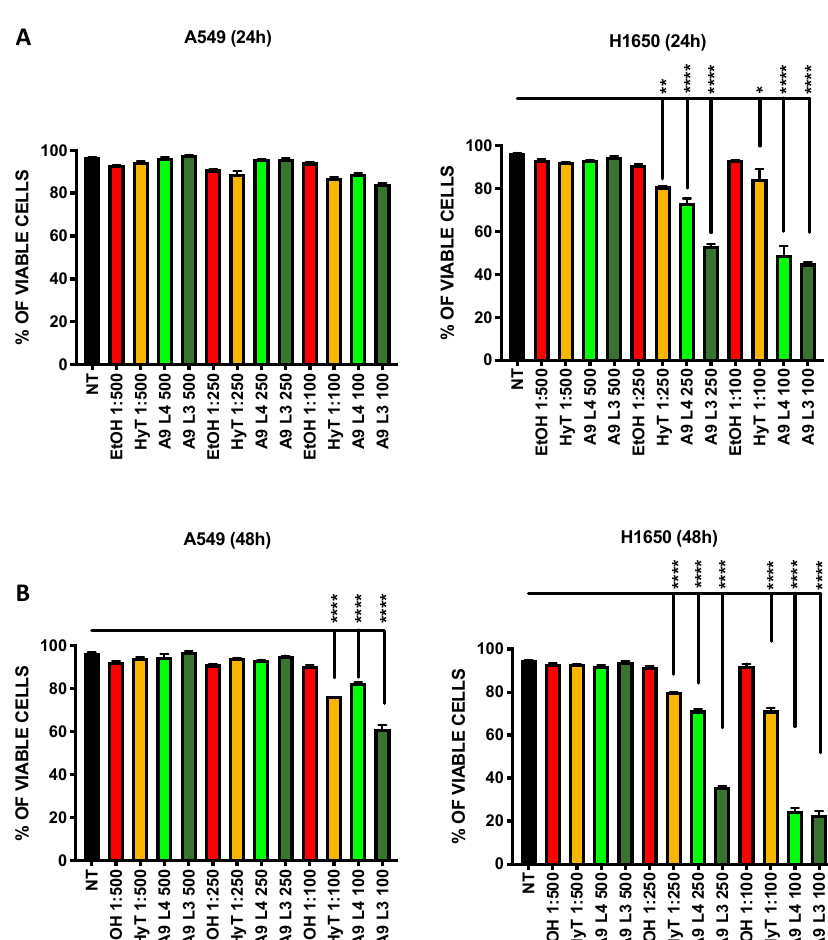
Figure 2. E ff ect of A009 extracts on the induction of apoptosis in vitro, in lung cancer cells. The lung carcinoma cell lines A549 (A-B) and H1650 (A-B) were treated for 24–48 h with 2 batches of A009 (L4 and L3), at dilutions 1; 500, 1: 250, 1: 100, or with hydroxytytosol (HyT) at the same concentration present in the dilutions of A009. The e ff ects on induction of apoptosis was evaluated by flow cytometry, following labeling with Propidium Iodide (PI) and AnnexinV. Results are shown as mean ± SEM, One Way ANOVA, * p < 0.5, ** p < 0.01, *** p < 0.001, **** p < 0.0001. NT (untreated); EtOH (ethanol vehicle used to dissolve hydroxytyrosol).